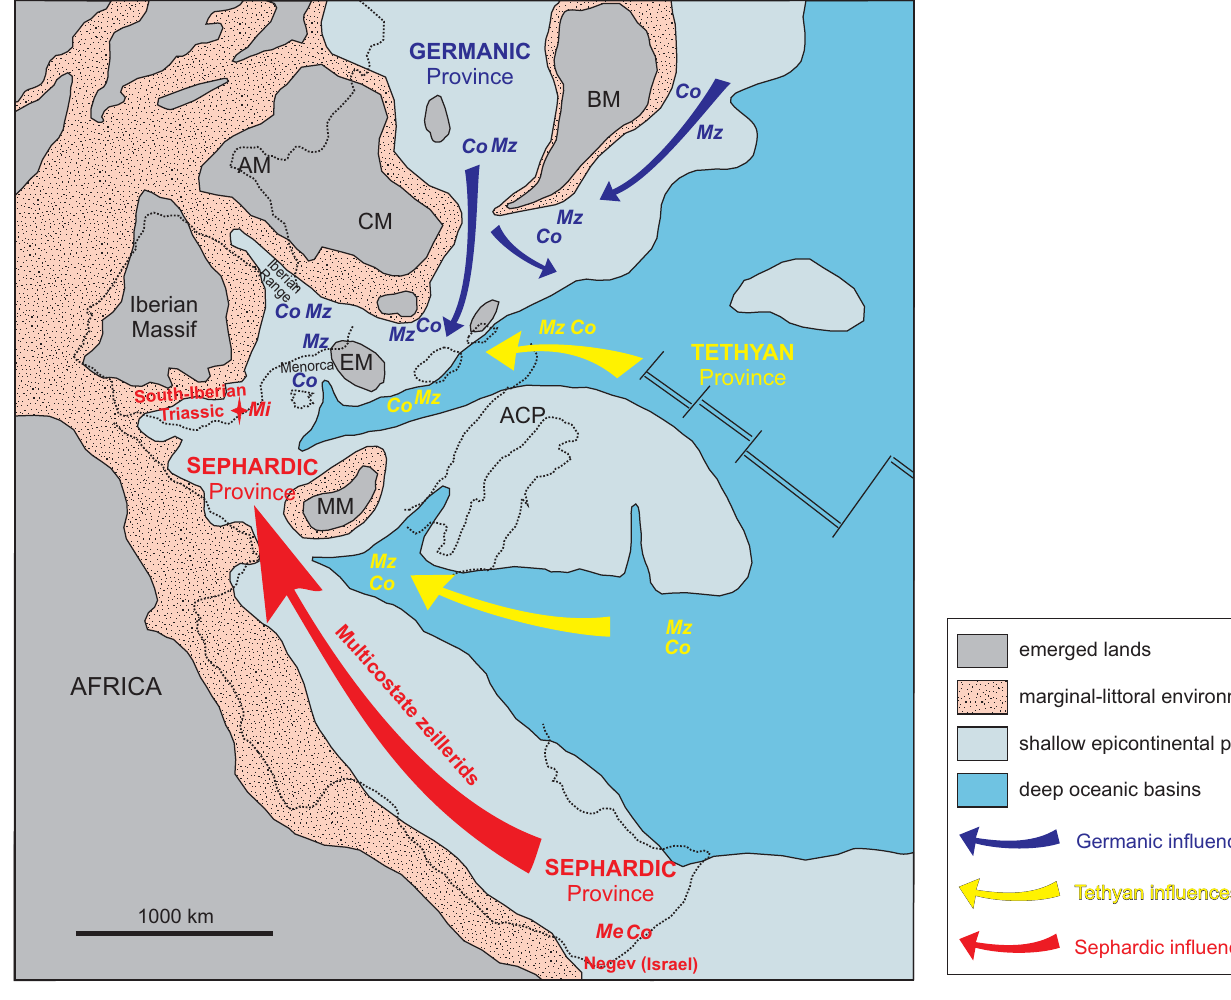
Fig. 6. Paleogeographical map of the Ladinian times (modified after Pérez-López and Pérez-Valera 2007), showing the distribution of taxa highly related to, or common with the brachiopod fauna inhabiting the Middle Triassic peri-Iberian platforms system. Color of arrows and taxa symbolizes the inferred paleobiogeographical affinities. ACP, Apennine Carbonate Platform; AM, Armorican Massif; BM: Bohemian Massif; CM, Central Massif; EM, Ebro Massif; MM, Meso-Mediterranean Massif; Mi , Misunithyris ; Me , Menathyris ; Mz , Mentzelia ; Co , Coenothyris. Occurrences mainly based on Schmidt (1935), Siblík (1972, 1988, 2001), Popiel-Barczyk and Senkowiczowa (1989), Dagys (1993), Török (1993), Kaim (1997), Torti and Angiolini (1997), Pálfy (2003), Feldman (2005, 2013), Ruban (2010), Escudero-Mozo et al. (2015), among others (see text for details). Dotted line shows palaeogeographic position of the currently emerged